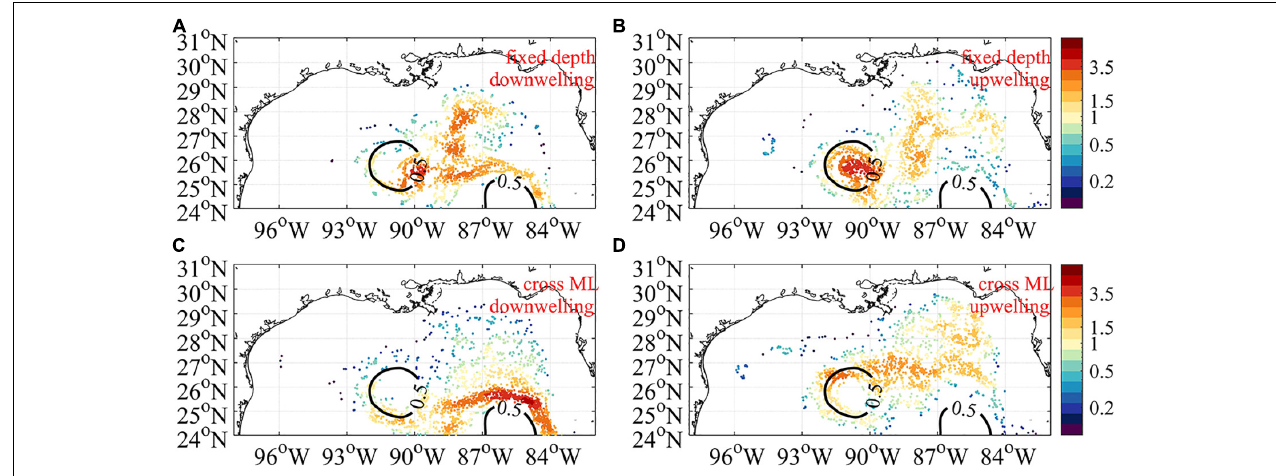
FIGURE 10 | KDE of particles selected based on their vertical absolute displacement after 10 days (A,B) and cross-mixed layer behavior (C,D) calculated considering all four winter MR releases. The particles are initially released at 5 m [panels (A,C) labeled as “downwelling”] and at deeper depths [ (B) release type 1; (D) release type 2, labeled as “upwelling”]. Black contours indicate the 0.5 m sea surface height isobaths and outline the location of the LC and the Ring.